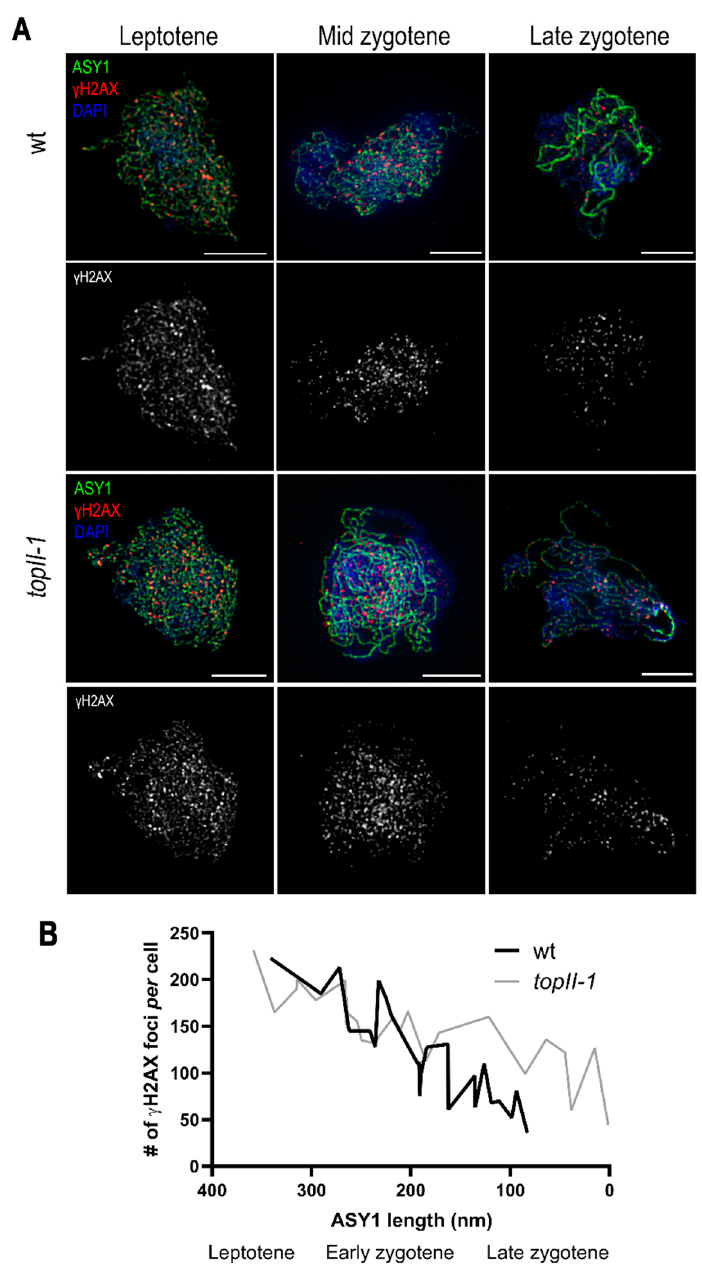
Figure 3. TOPII is needed for the timely progression of meiotic DSB repair. ( A ) ASY1 (green) and γ H2AX (red) staining of early prophase I wt and topII-1 meiocytes. ( B ) γ H2AX foci distribution per cell vs. ASY1 length (nm). Scale bars: 5 µm.